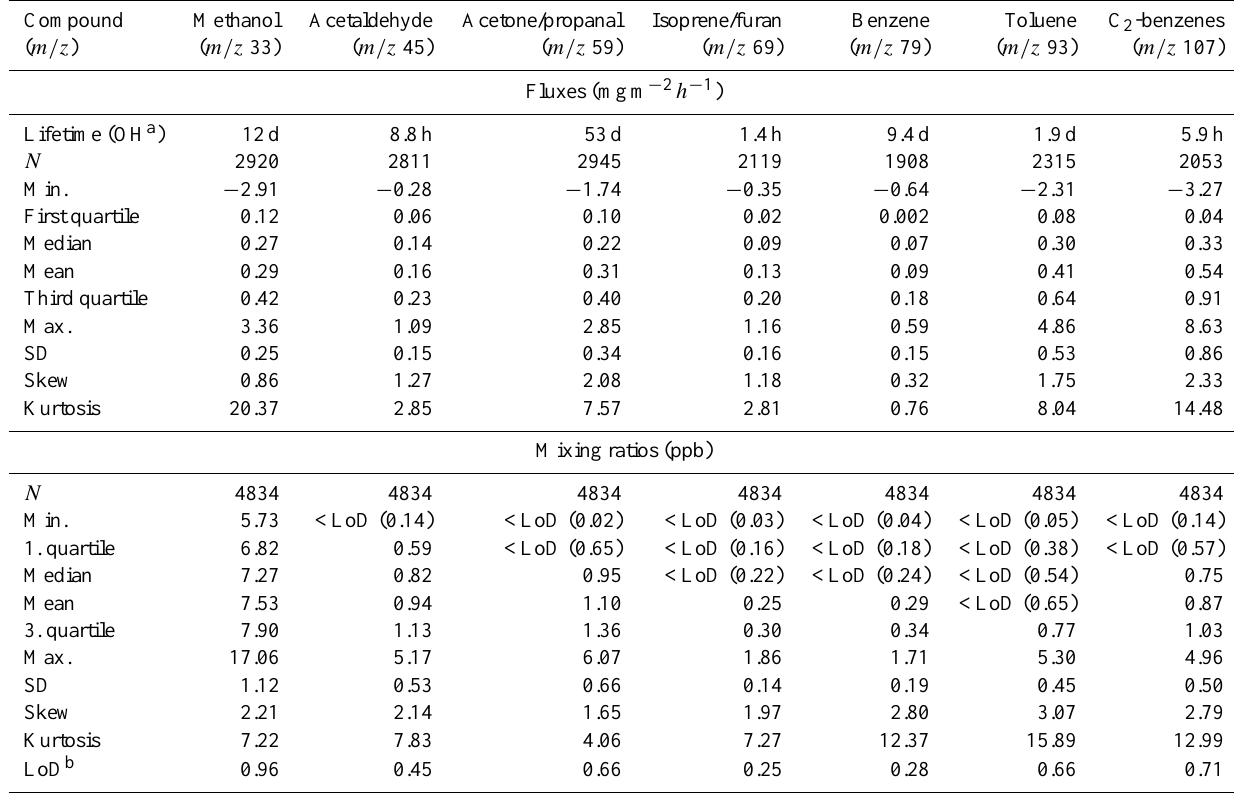
Table 2. Summary of 25min VOC fluxes and mixing ratios above central London during August–December 2012. Compound Methanol Acetaldehyde Acetone/propanal Isoprene/furan Benzene Toluene C 2